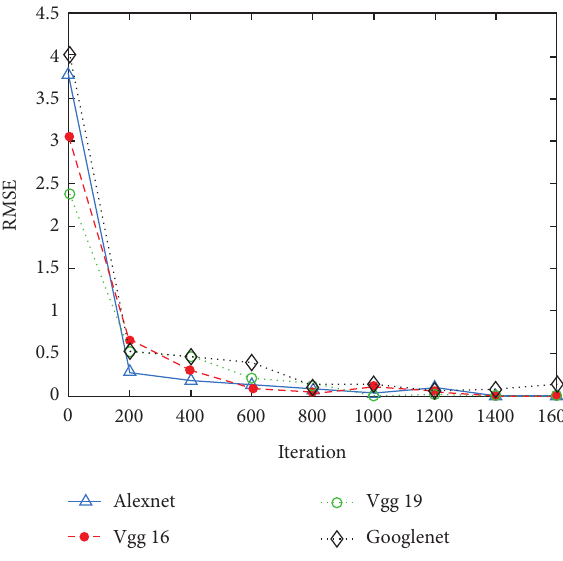
Figure 8: Training process of traditional network.